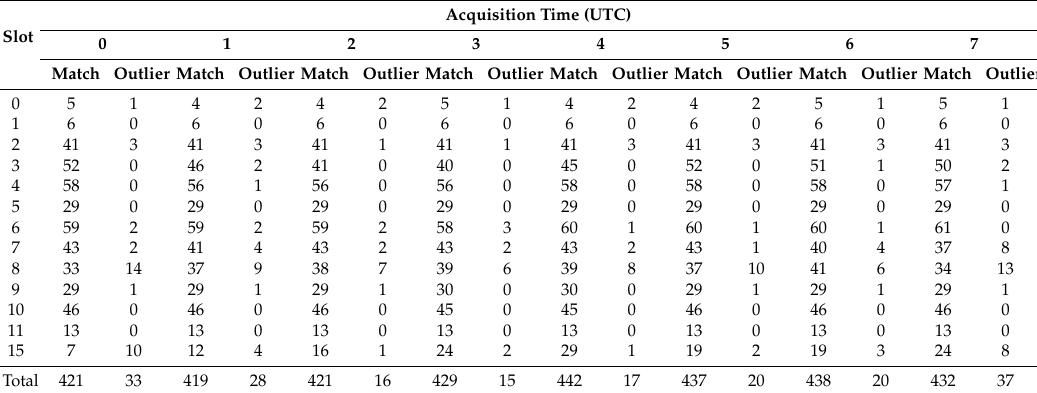
Table 2. Shoreline-matching result (before RANSAC).